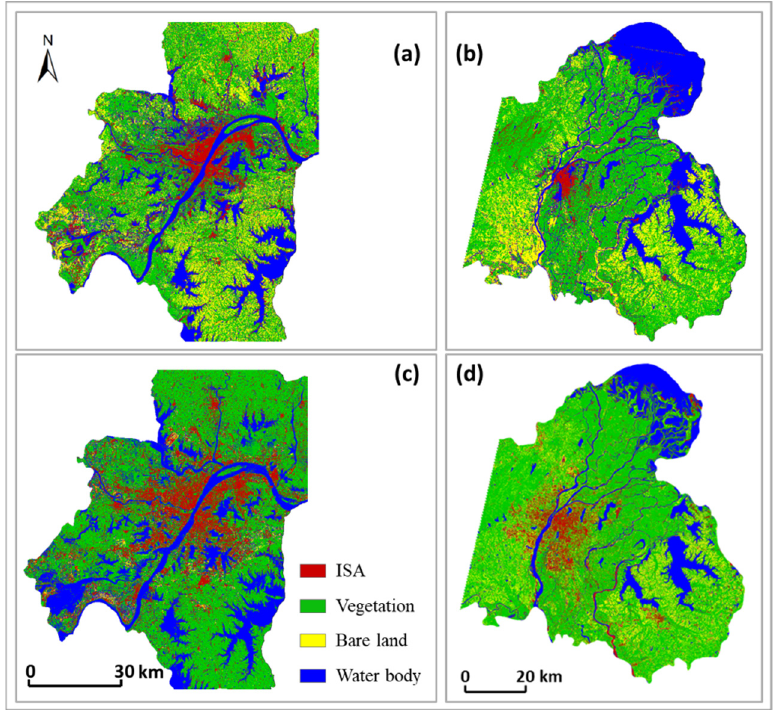
Figure 8. The land cover maps for Wuhan and Nanchang. ( a ) The land covers in Wuhan on 26 September 1987. ( b ) The land covers in Nanchang on 17 October 1988. ( c ) The land covers in Wuhan on 23 July 2016. ( d ) The land covers in Nanchang on 14 September 2017. For the past 35 years (1984–2018), an obvious expansion could be seen for center 1. In the beginning, center 1 was a small section located on the eastern bank of the Ganjiang River. With the development of Nanchang, center 1 gradually expanded. Different from the development of the eastern bank of the Ganjiang River, the highest LST on the western bank of the Ganjiang River was scattered at the outset, and gradually gathered as time went by, finally combining with the eastern part and turning into a large center. The extent of center 1 was 10.75 km 2 in 1984, and it changed into 398.82 km 2 in 2018. Center 1 has expanded 37 times compared to its original extent. Center 2 was not obvious before 2002. Most parts of the southeastern area in Nanchang presented as the highest LST before 2002.